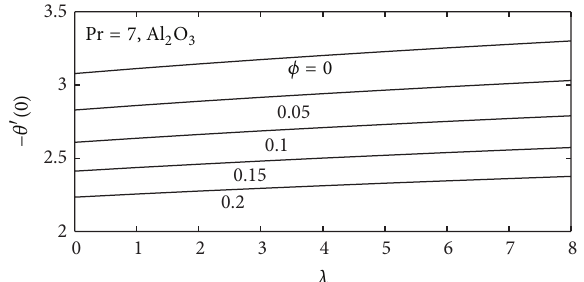
Figure 4: Variation of 𝑓 󸀠󸀠 (0) with 𝜆 for different types of nanopar- ticles when Pr = 7 and 𝜙 = 0.1 .